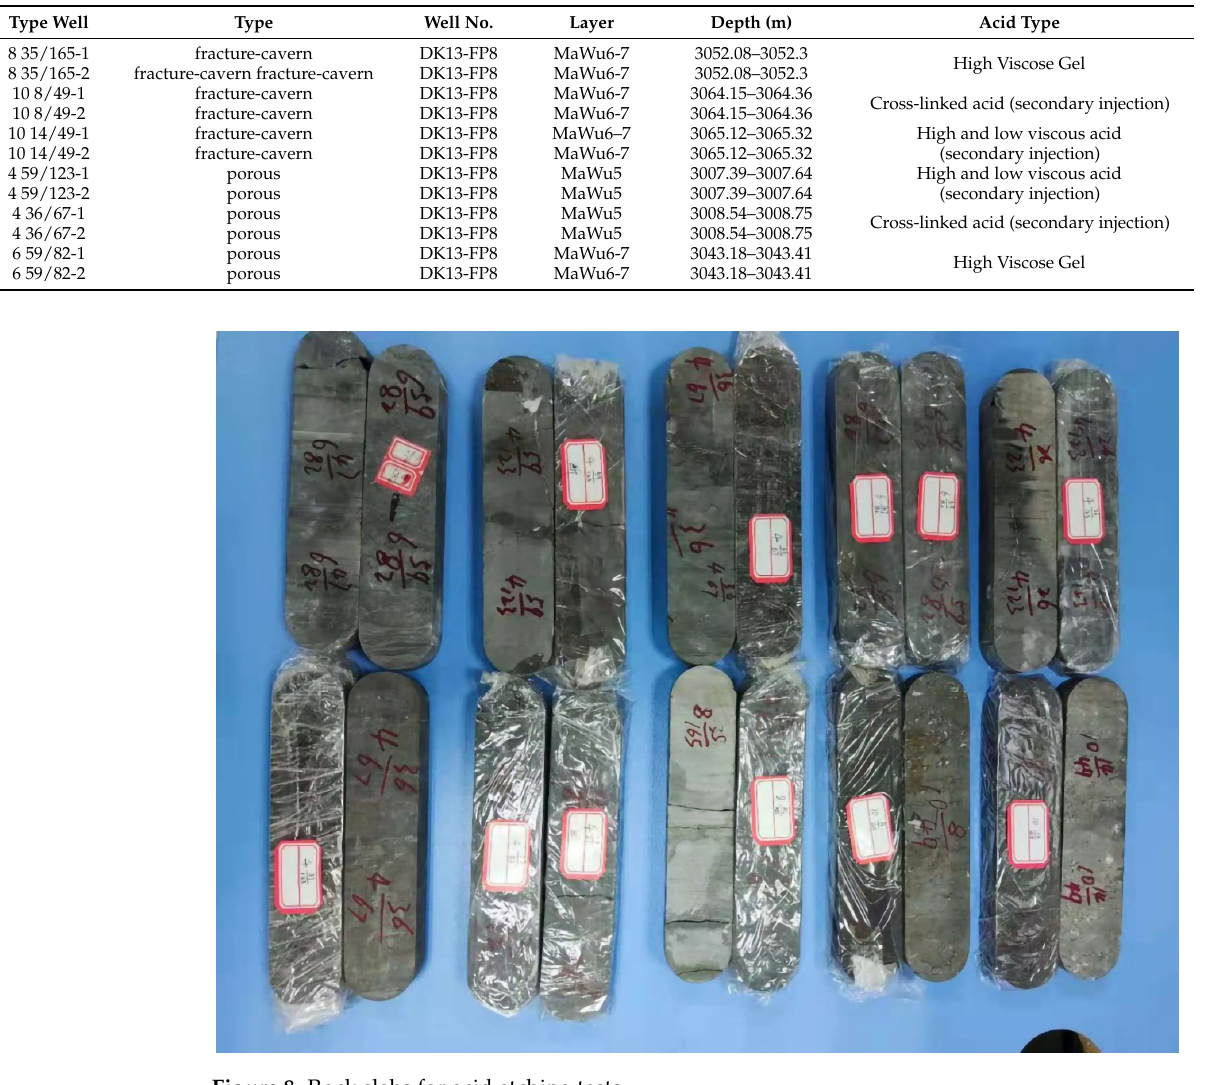
Figure 8. Rock slabs for acid etching tests.